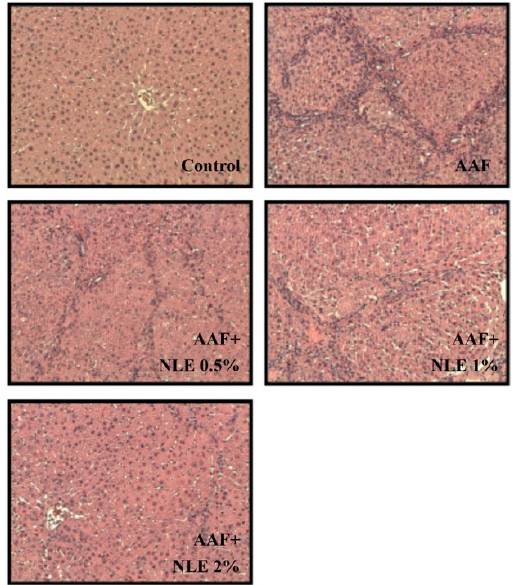
Figure 1. E ff ect of Nelumbo nucifera (NLE) supplementation on 2-acetylaminofluorene (AAF)-induced liver fibrosis in rats. Rats were fed a normal diet (as the control group), a normal diet containing AAF (as the AAF group), a normal diet containing AAF with 0.5% NLE (as the AAF + NLE 0.5% group), a normal diet containing AAF with 1% NLE (as the AAF + NLE 1% group), and a normal diet containing AAF with 2% NLE (as the AAF + NLE 2% group) for 12 weeks. Collagen fibers were stained by Masson’s trichrome (blue).